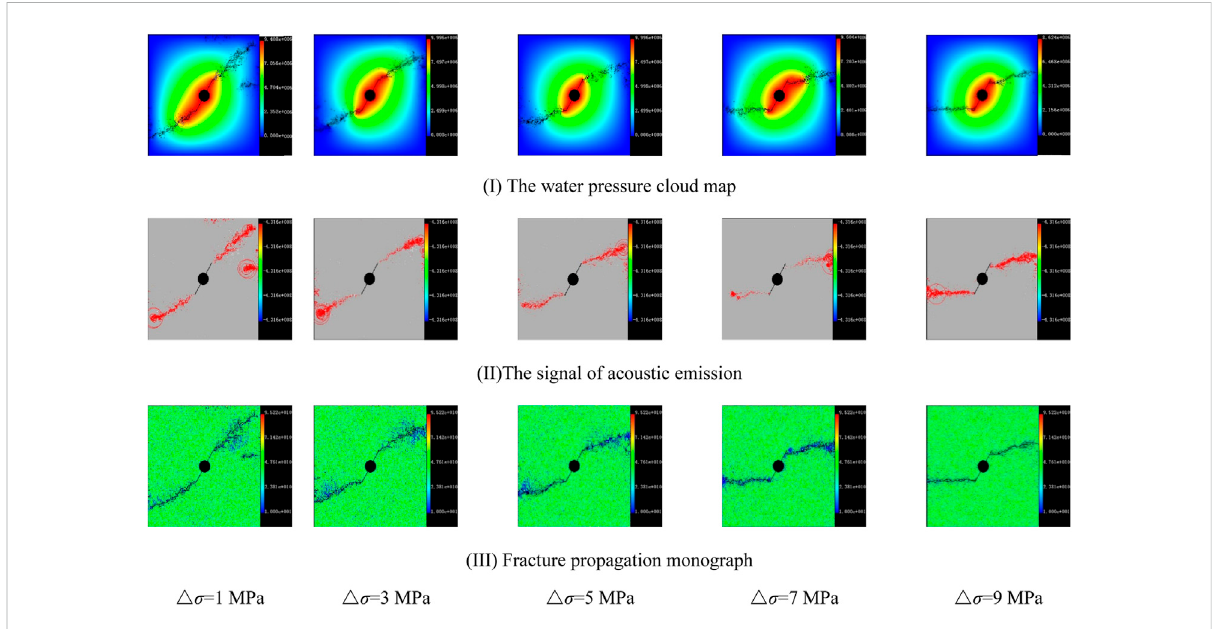
FIGURE 6 Water pressure, AE signal, and fracture de fl ection morphology under different △ σ